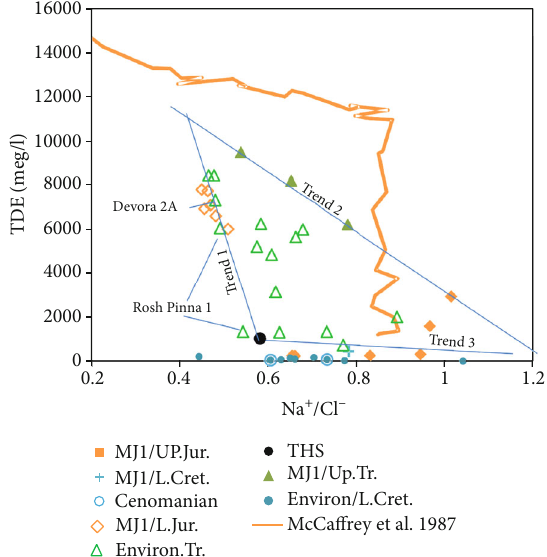
Figure 4: Total dissolved equivalents. TDE vs. Na + /Cl - showing dilution and mixing processes. Ratios are based on meq/l. Trend 1: mixing of Devora 2A and THS; trend 2: mixing of MJ1 and basaltic-rock water; trend 3: mixing of HTS and basaltic-rock water.